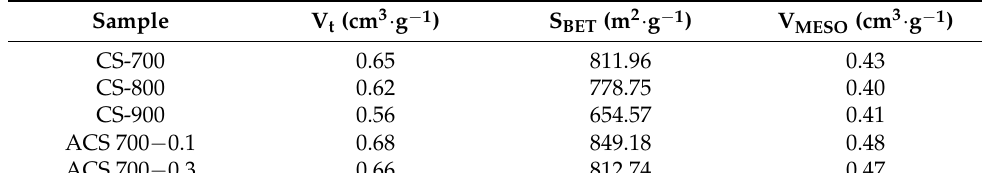
Figure 3. Sulphur 2p spectra of ( a ) resin gel, CS 700, CS 800, and CS 900; ( b ) Whole XPS spectra of CS 700, CS 800, and CS 900; ( c ) C1s spectra of CS 700, CS 800, and CS 900. ( d – f ) Deconvoluted C1s spectra of CS 700, CS 800, and CS 900.